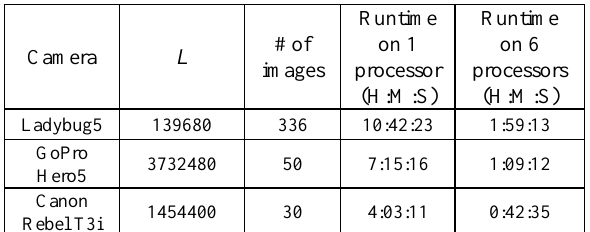
Figure 9. Height measurement error simulation for targets at 4 metres